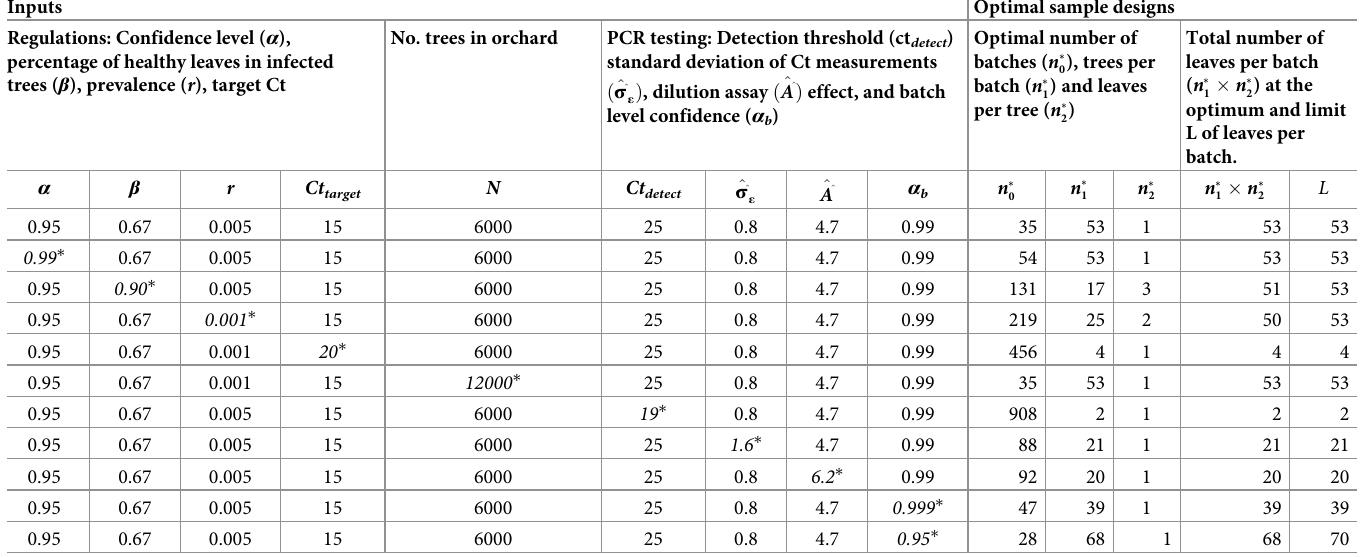
Table 2. Optimal sample sizes for a selection of inputs. Inputs Optimal sample